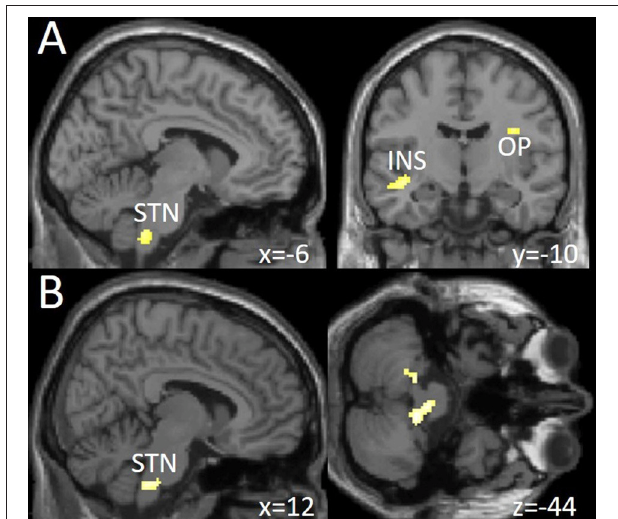
FIGURE 3 | (A) Increased neuronal activity following trigeminal nociceptive input after drug withdrawal in spinal trigeminal nucleus (STN), insula (INS), and operculum (OP) at a visualization threshold of p < 0.001 uncorrected. (B) Increase of functional connectivity by means of a psychophysiological interaction (PPI) analysis from OFC/MOG to spinal trigeminal nucleus (STN) and the cerebellum during drug withdrawal in the patient group. Shown at a visualization threshold of p < 0.001, uncorrected. Coordinates are given according to the MNI